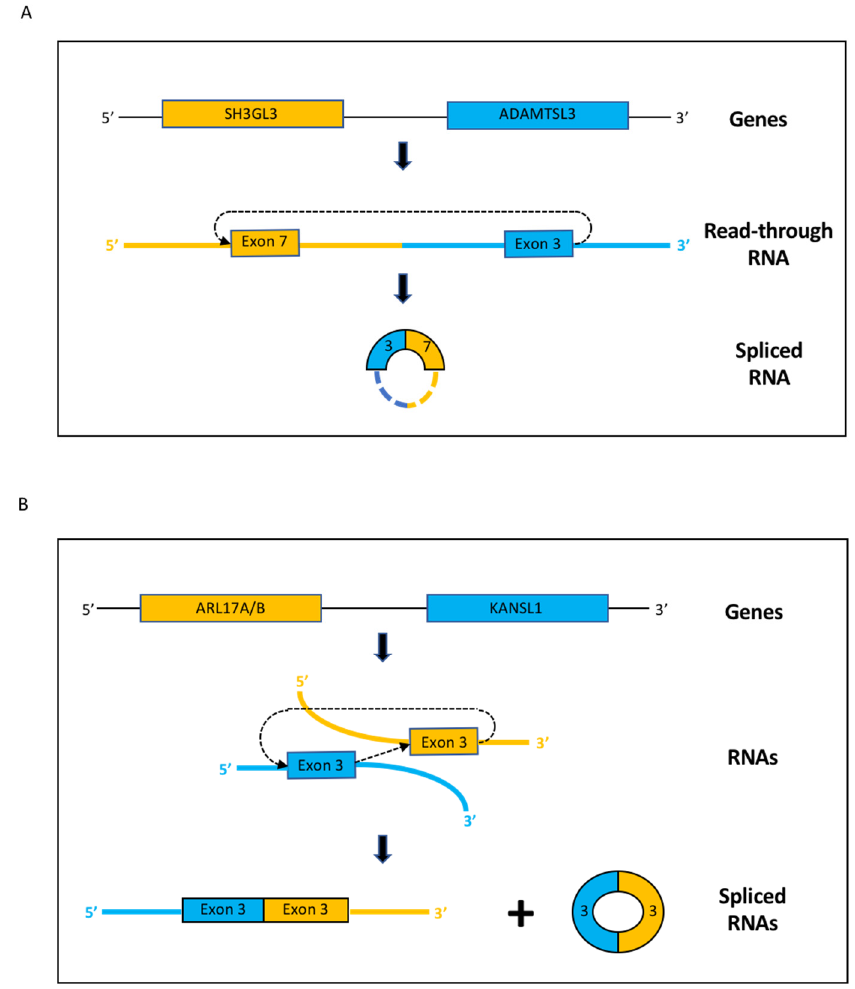
Figure 4. Schematic representation of molecular events leading to the observed ADAMTSL3–SH3GL3 circular fusion and the KANSL–ARL17A/B linear and circular fusions. ( A ) Read-through transcripts from the SH3GL3 gene extend into the downstream ADAMTSL3 gene, followed by back-splicing of exon 3 of ADAMTSL3 to exon 7 of SH3GL3. The resulting circle may or may not include additional ADAMTS3 or SH3GL3 exons, indicated by hatched lines on the diagram. ( B ) Transcripts from the KANSLI1 and ARL17A/B gene bring in proximity the exon 3 of KANSL1 to the exon 3 of ARL17A/B. The 3 (cid:48) end of KANSLI1 exon 3 trans-splices to the 5 (cid:48) end of ARL17A/B exon 3 producing the observed KANSLI1–ARL17A/B linear fusion. In cases where a back-splicing event also occurs, with the 3 (cid:48) end of ARL17A/B exon 3 joining the 5 (cid:48) end of KANSL1 exon 3, a circular RNA composed of these two exons is